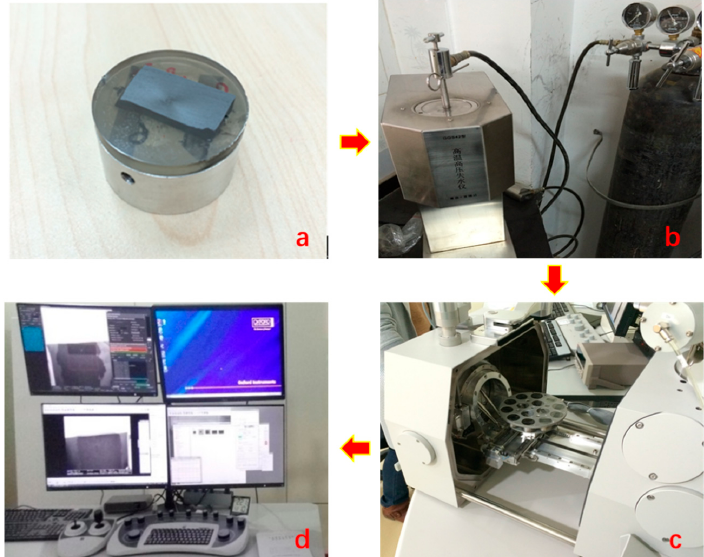
Figure 4. Experimental setup for shale hydration observation under specific temperature